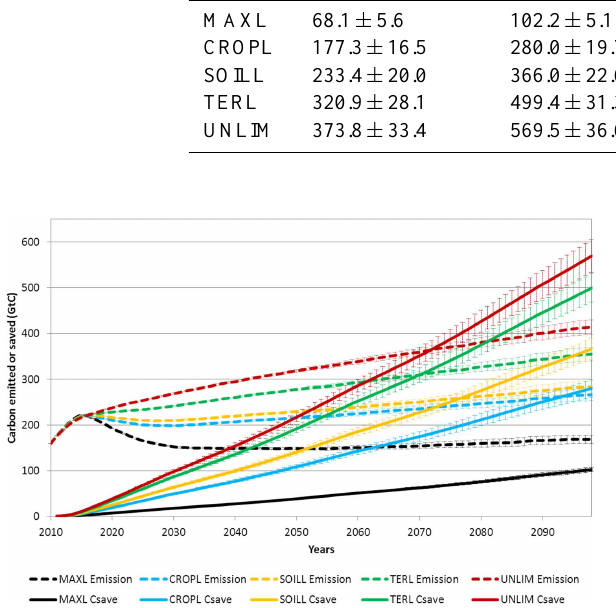
Fig. 12. Time to repay carbon debt for the respective scenarios. We show the total emissions incurred due to bioenergy cultivation (dashed line) and the carbon emissions saved potentially for each of the scenarios through avoided use of fossil fuels (solid line) with each color unique to the respective land management scenarios. The time taken for the lines of the respective scenarios (colors) to inter- sect gives us the time to repay the carbon debt. While the thick or dashed line represents the mean of 19 values, the uncertainty (1 standard deviation) is shown by the error bars.